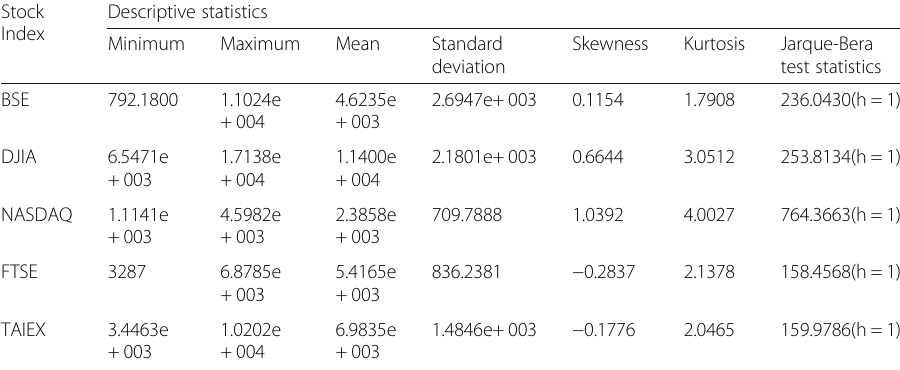
Table 3 Descriptive statistics from BSE, DJIA, NASDAQ, FTSE, and TAIEX financial time series